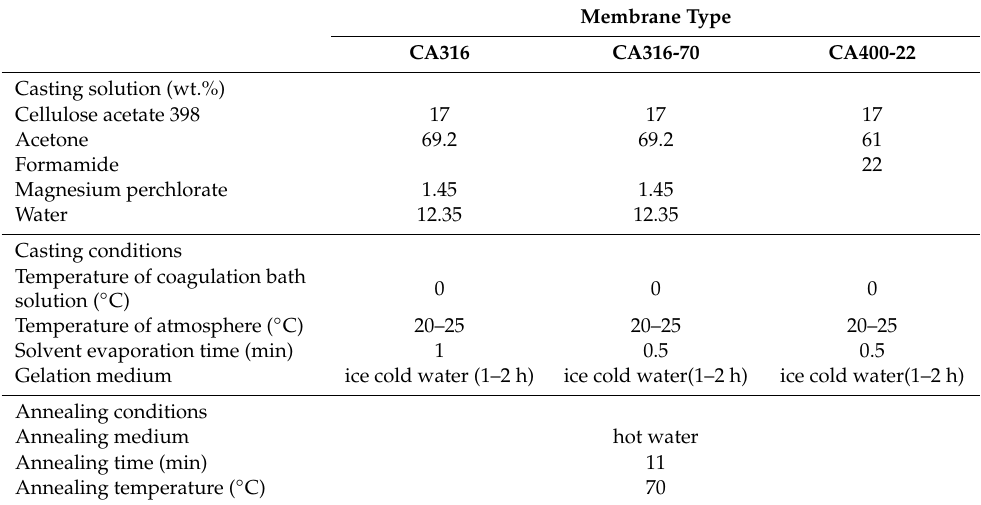
Table 1. Film casting conditions and casting solutions used for the production of nanofiltration (NF)